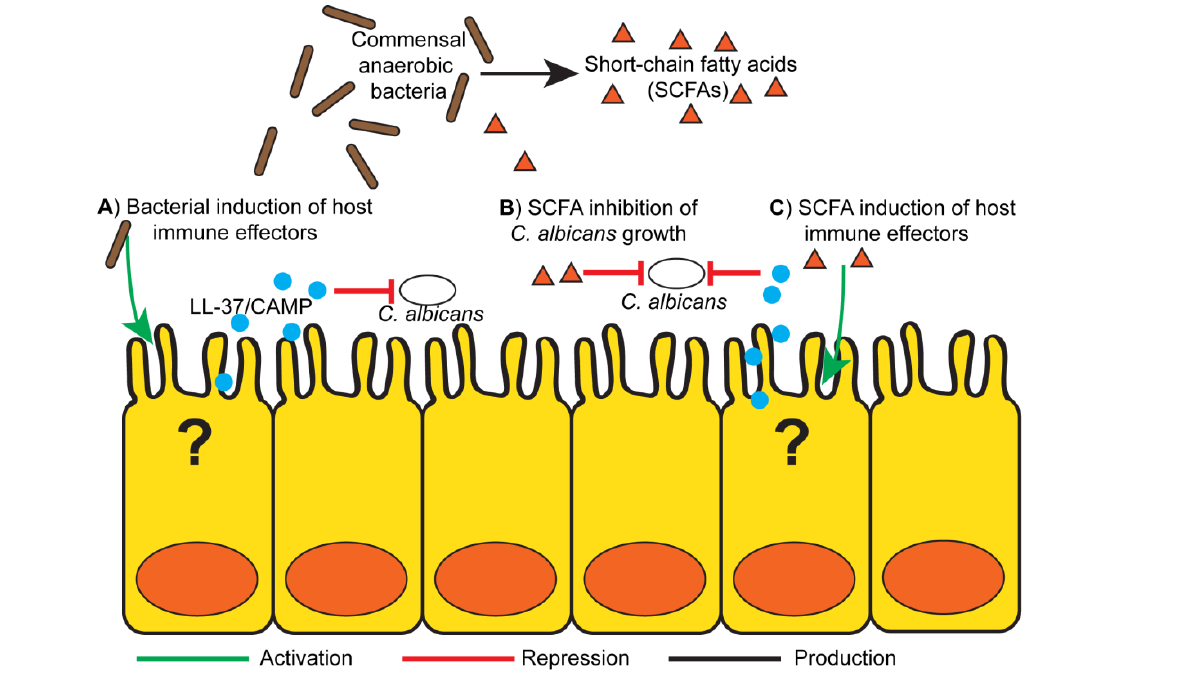
Figure 1: Proposed mechanism of gut bacteria mediated Candida albicans gastrointestinal colonization resistance. (A ) Commensal gut bacteria, particularly obligate anaerobes (i.e. Bacteriodetes thetaiotamicron , Blautia producta ), induce production of colonic host immune effectors, specifically antimicrobial peptides such as LL-37/CAMP which have Candicidal activity. ( B ) Bacterially derived fermentation prod- ucts, short-chain fatty acids (SCFAs) may have a direct effect on C. albicans growth and colonization. ( C ) SCFAs can induce production of colonic antimicrobial peptides, including cathelicidins (LL-37/CAMP) and defensins that have activity against C. albicans